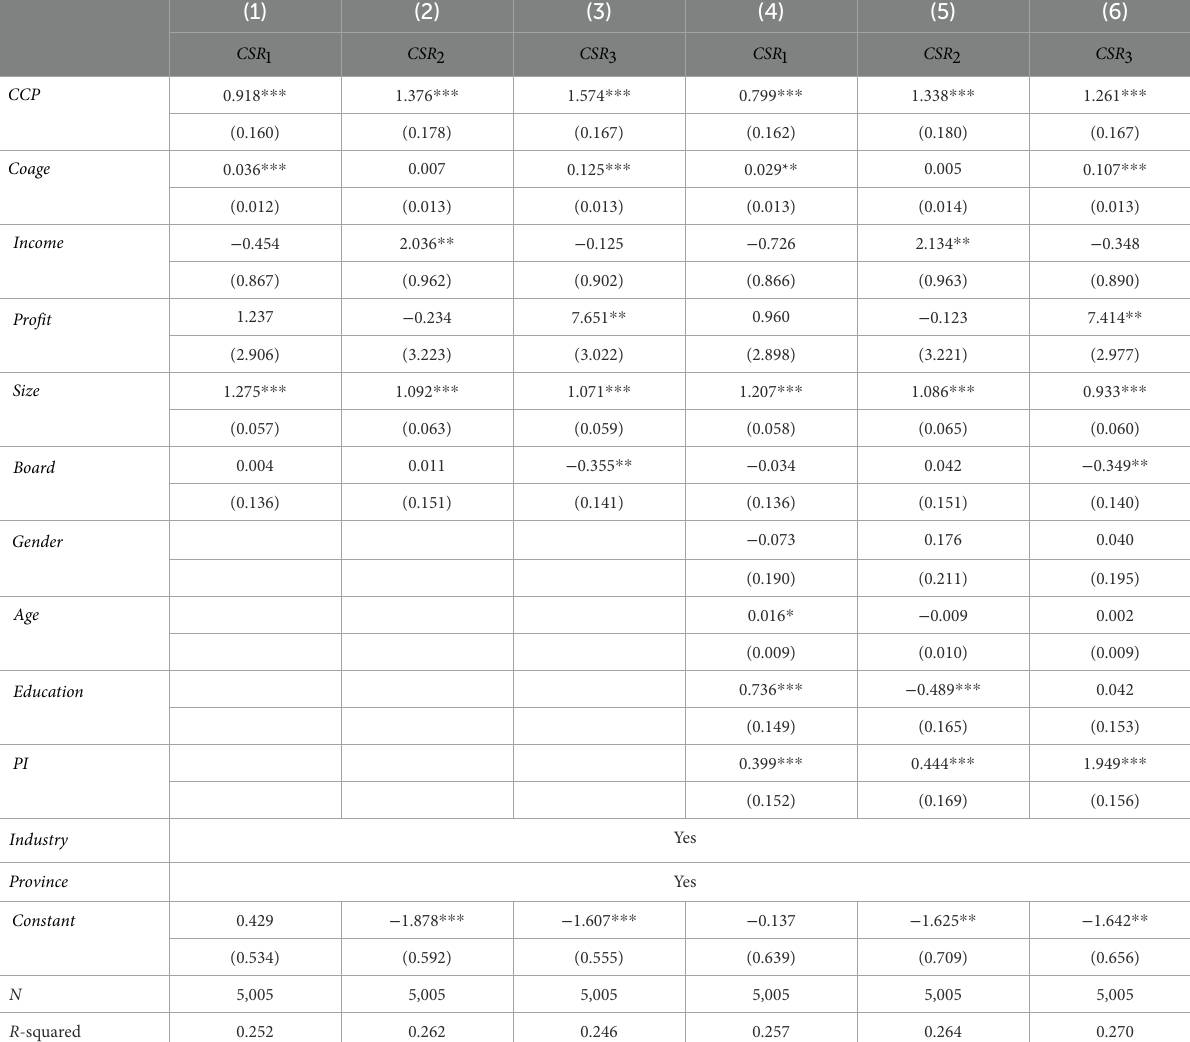
TABLE 3 Party branches and CSR in Chinese private enterprises: OLS